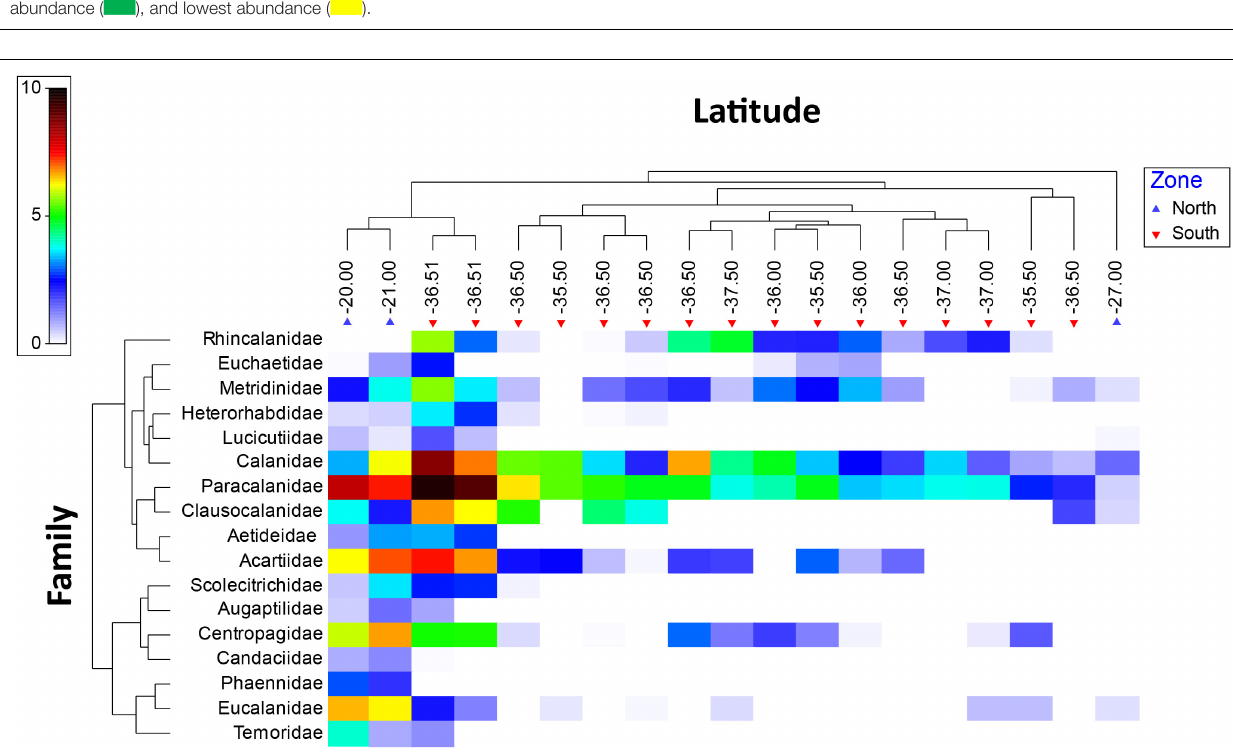
FIGURE 6 | Shade plot of mean abundances [transformed by log (x + 1)] of the families found in the 0–200 m layer, over the north-south (alongshore) gradient from 2002 to 2015 in the southeast Pacific off the Chilean coast. Oceanographic regions were defined as north and south divided by the subtropical convergence (30 ◦ S). The color scale represents transformed abundance for each